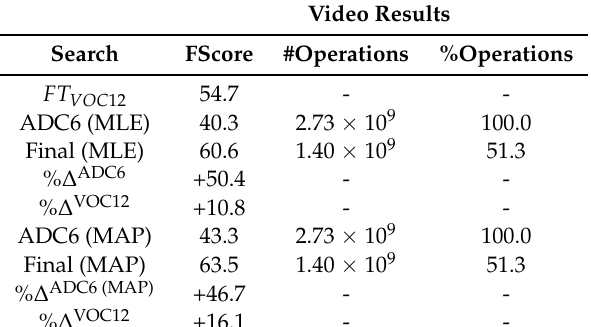
Table 10. Final adaptation system for each video average results.